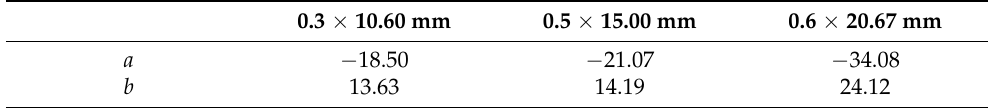
Table 2. Values of characteristic parameters a and b